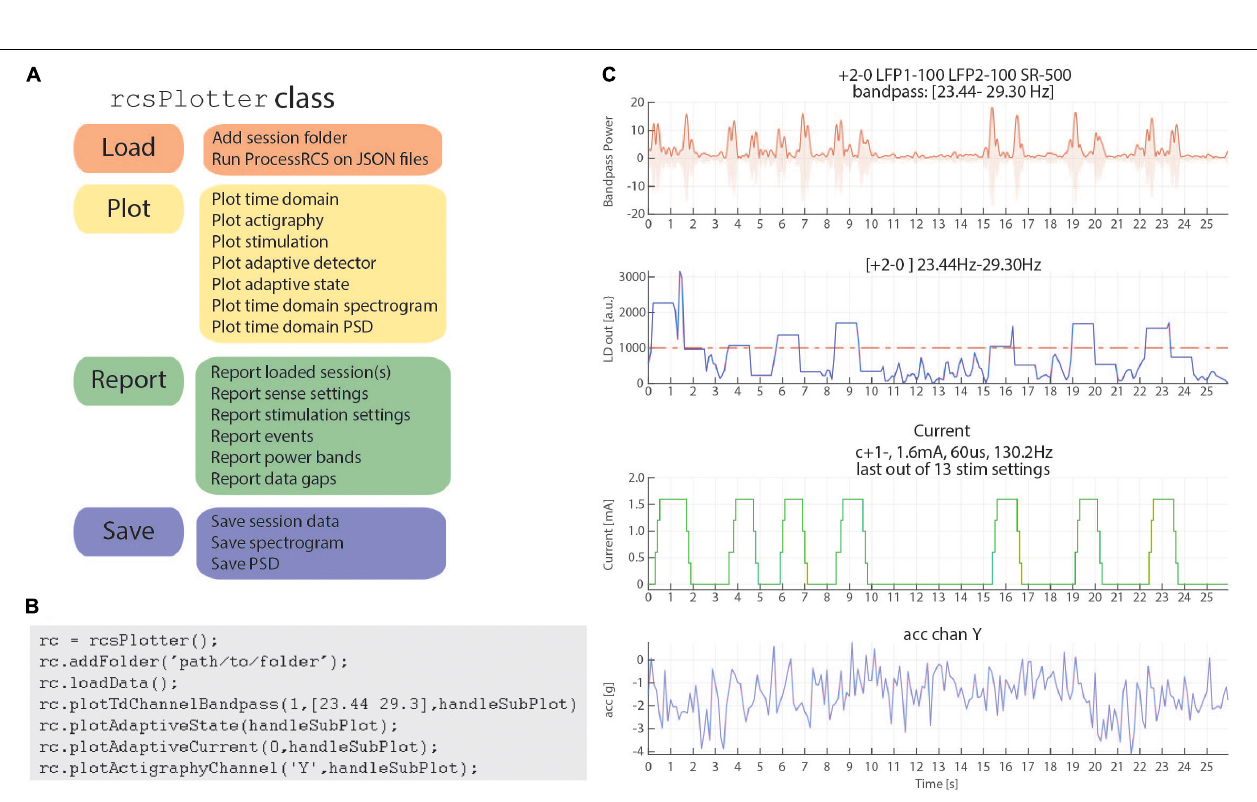
Frontiers in Human Neuroscience |